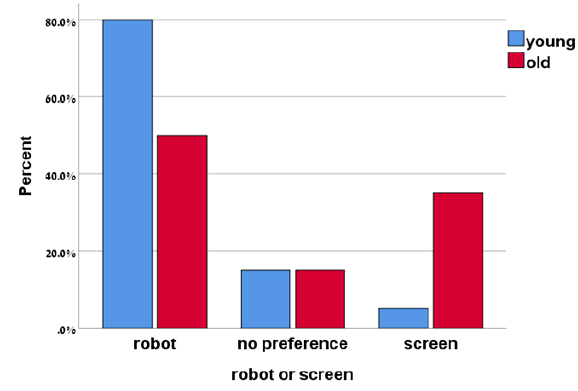
Figure 4: A summary of the preferences of both age groups in Ex- periment 2: robot, screen or no preference. Results are shown as percentage of each group.